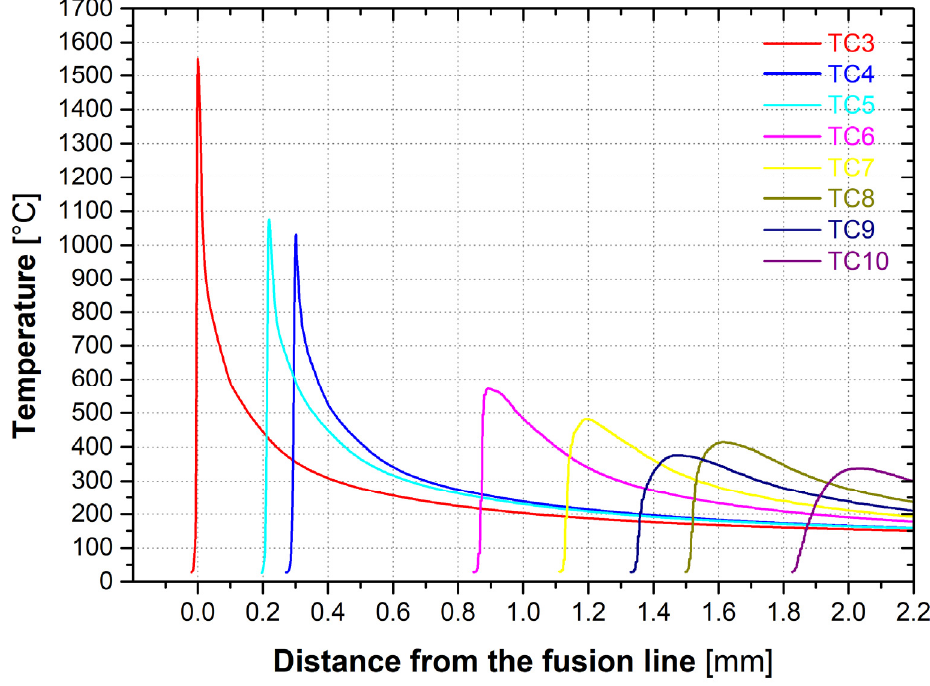
Figure 10. Temperature cycles (offset to correspond to the actual distance from the fusion line)—heat input value 8 kJ·cm − 1 .